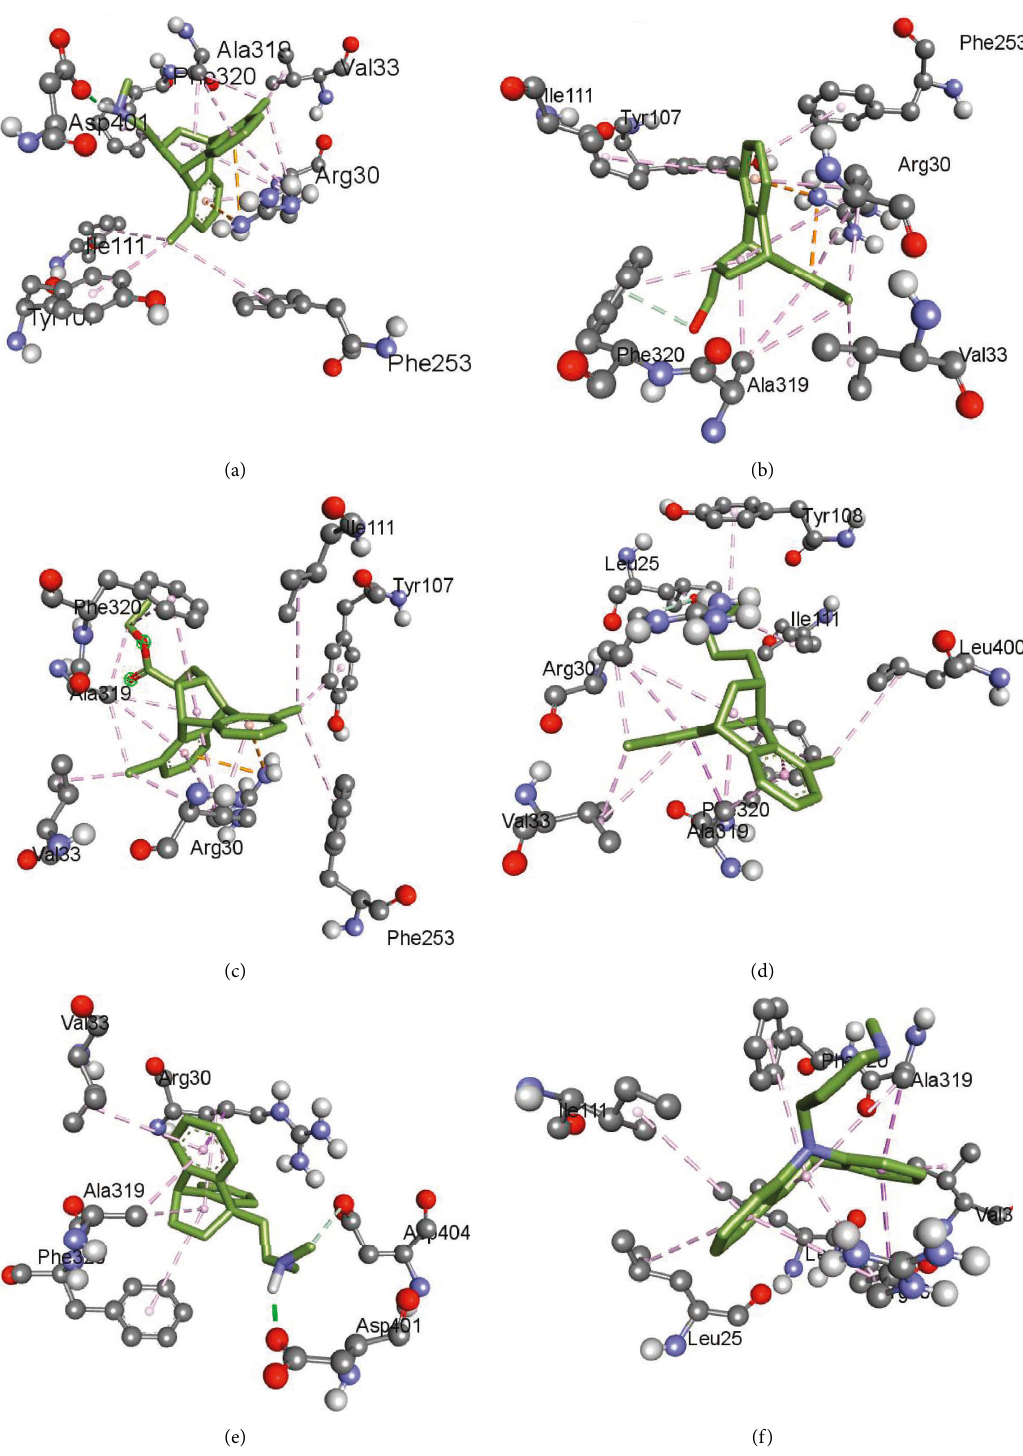
Figure 8: Binding modes of (a) compound 1 , (b) compound 2 , (c) compound 5, (d) compound 6 , (e) standard drug maprotiline, and (f) the native ligand, desipramine at the central binding site of Leu